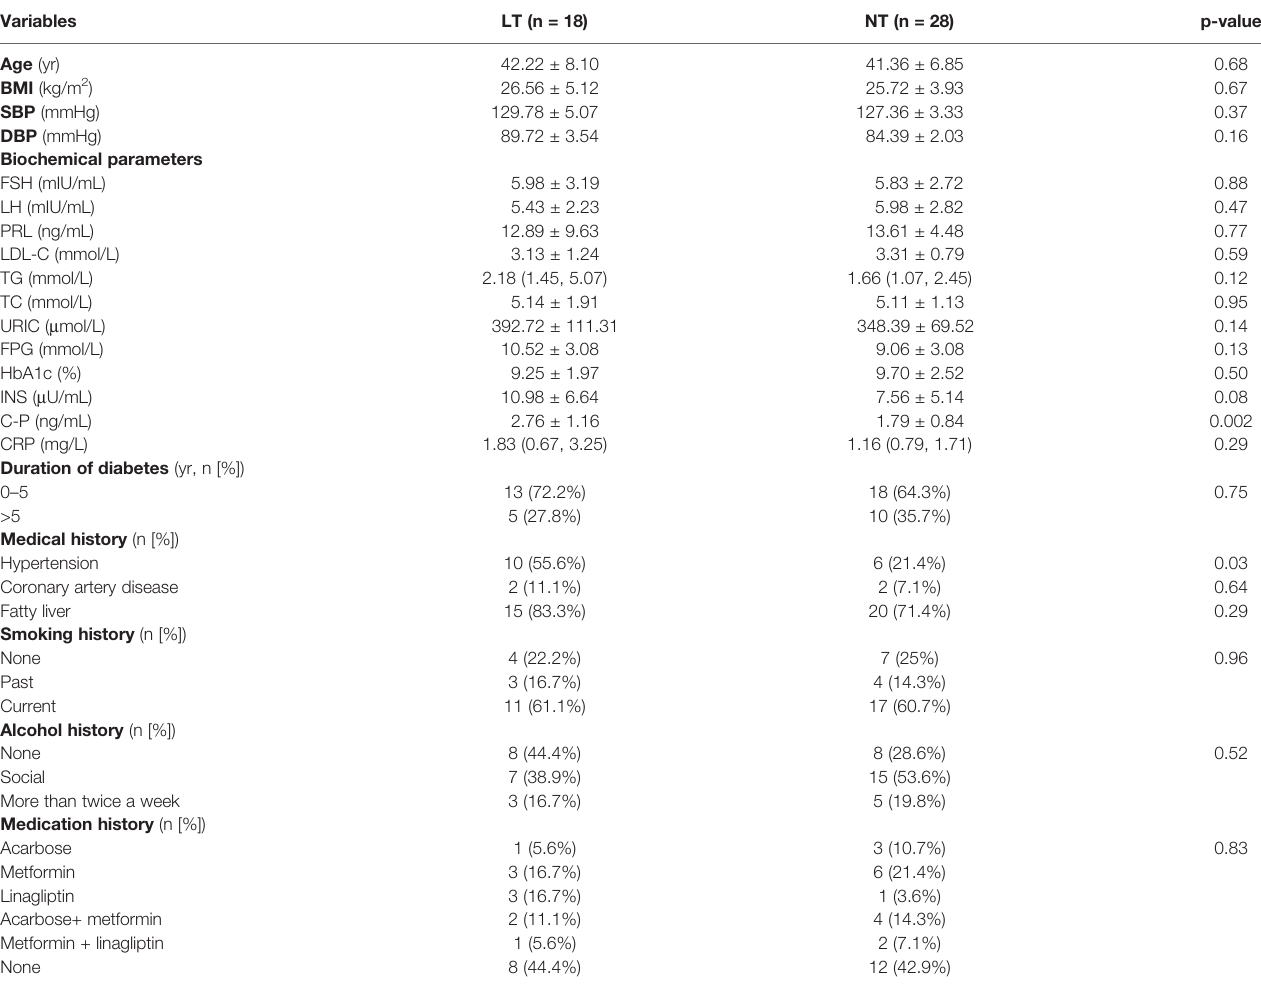
TABLE 1 | Clinical